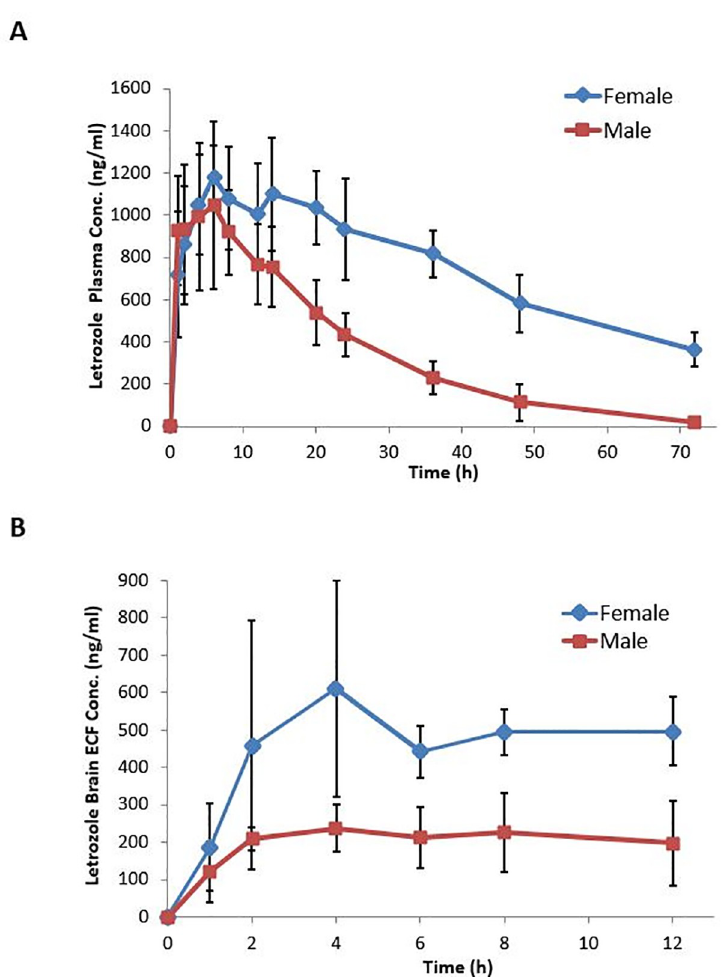
Fig 2. Male versus female letrozole plasma and brain ECF concentration-time profiles in Sprague- Dawley rats. Following single dose administration of letrozole (4 mg/kg), A) Plasma samples were collected through the jugular vein catheters at discrete time intervals from 0–72 hours; B) Microdialysate samples were collected simultaneously with plasma samples up to 12 hours. Dialysate concentrations were corrected for in vitro recovery of 7.2%. Data; mean ±